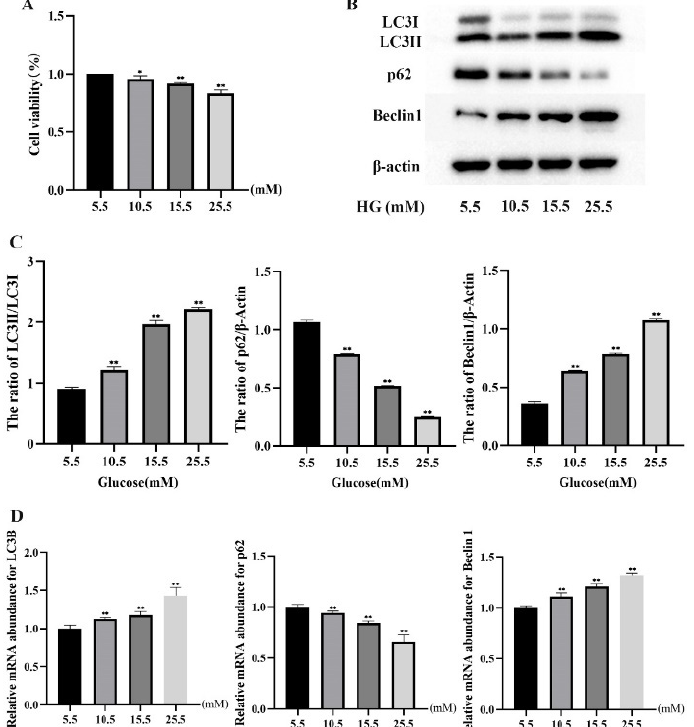
Figure 1. Effects of different concentrations of glucose on autophagy in MDBK cells. MDBK cells were treated with 5.5, 10.5, 15.5, and 25.5 mM glucose for 24 h, respectively. Western blot, qRT-PCR, and CCK-8 assay were used to assess protein expression, gene expression, and cell viability, respectively. ( A ) The cell viability; ( B , C ) The protein level of LC3-II/I, p62, and Beclin1; ( D ) The mRNA expression level of LC3B, p62, and Beclin1. * p < 0.05 and ** p < 0.01 compared with control group.